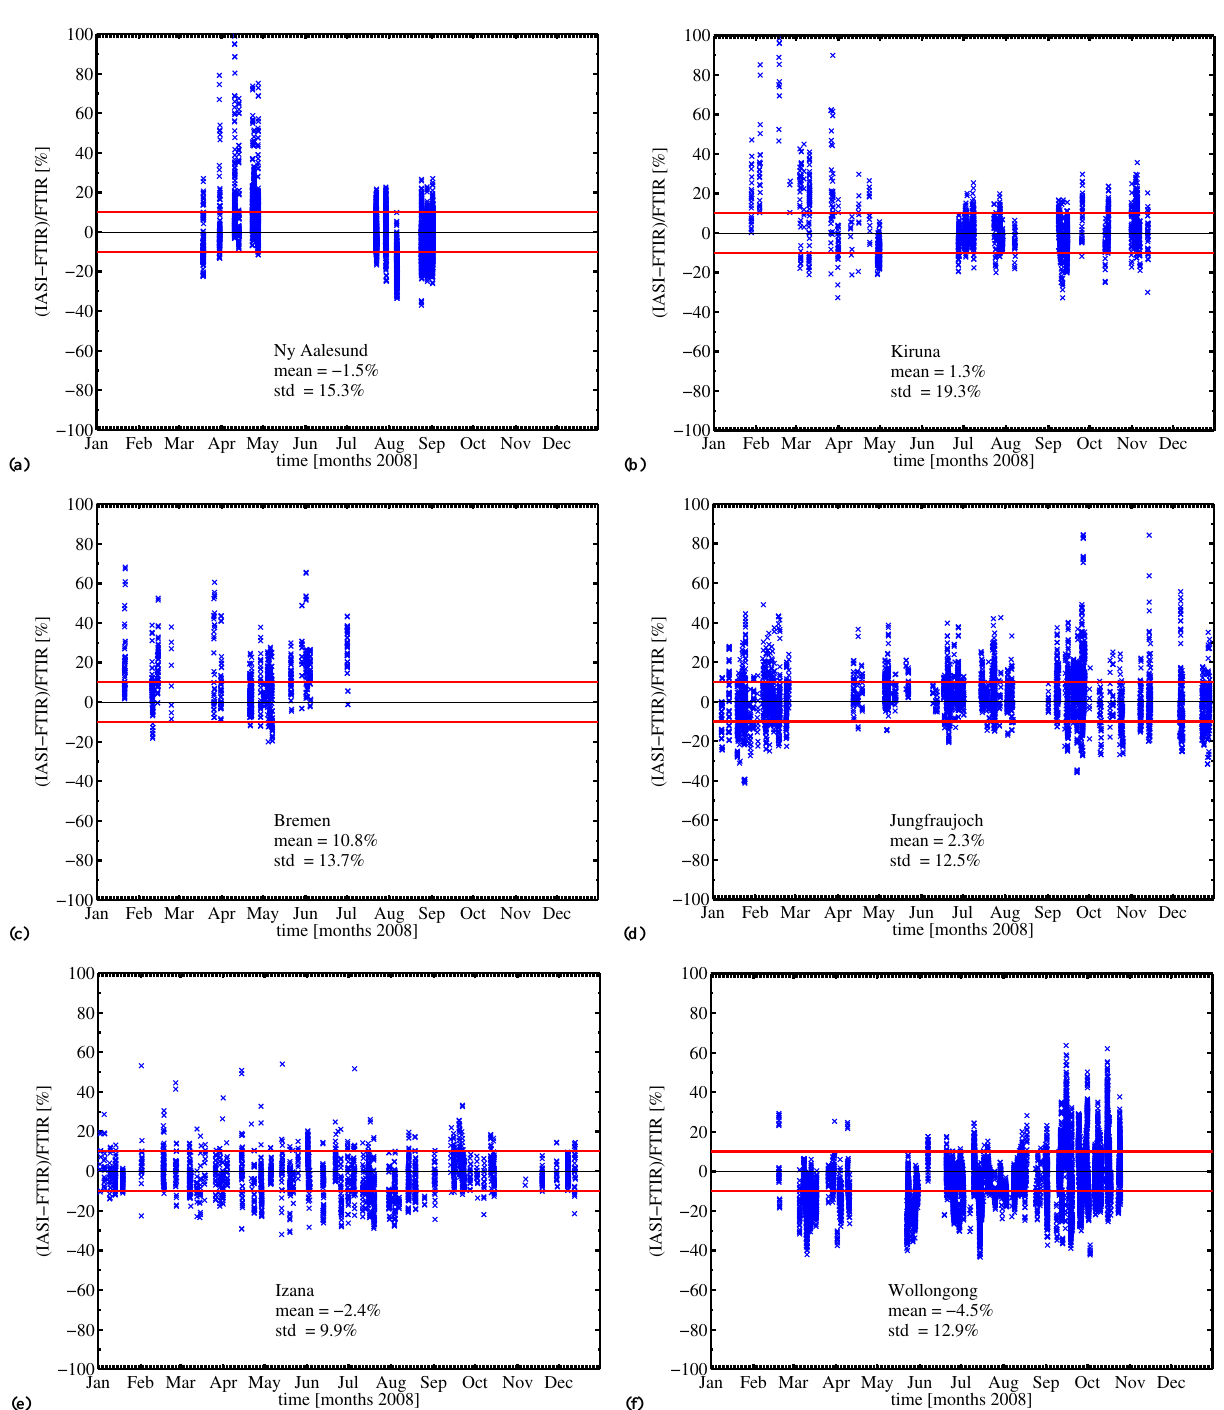
Fig. 5. Relative differences of the smoothed and altitude-corrected FTIR CO total column and the IASI CO total column of all the comparison pairs for (a) Ny- ˚Alesund, (b) Kiruna, (c) Bremen, (d) Jungfraujoch, (e) Iza˜na and (f) Wollongong. The red lines indicate ± 10%